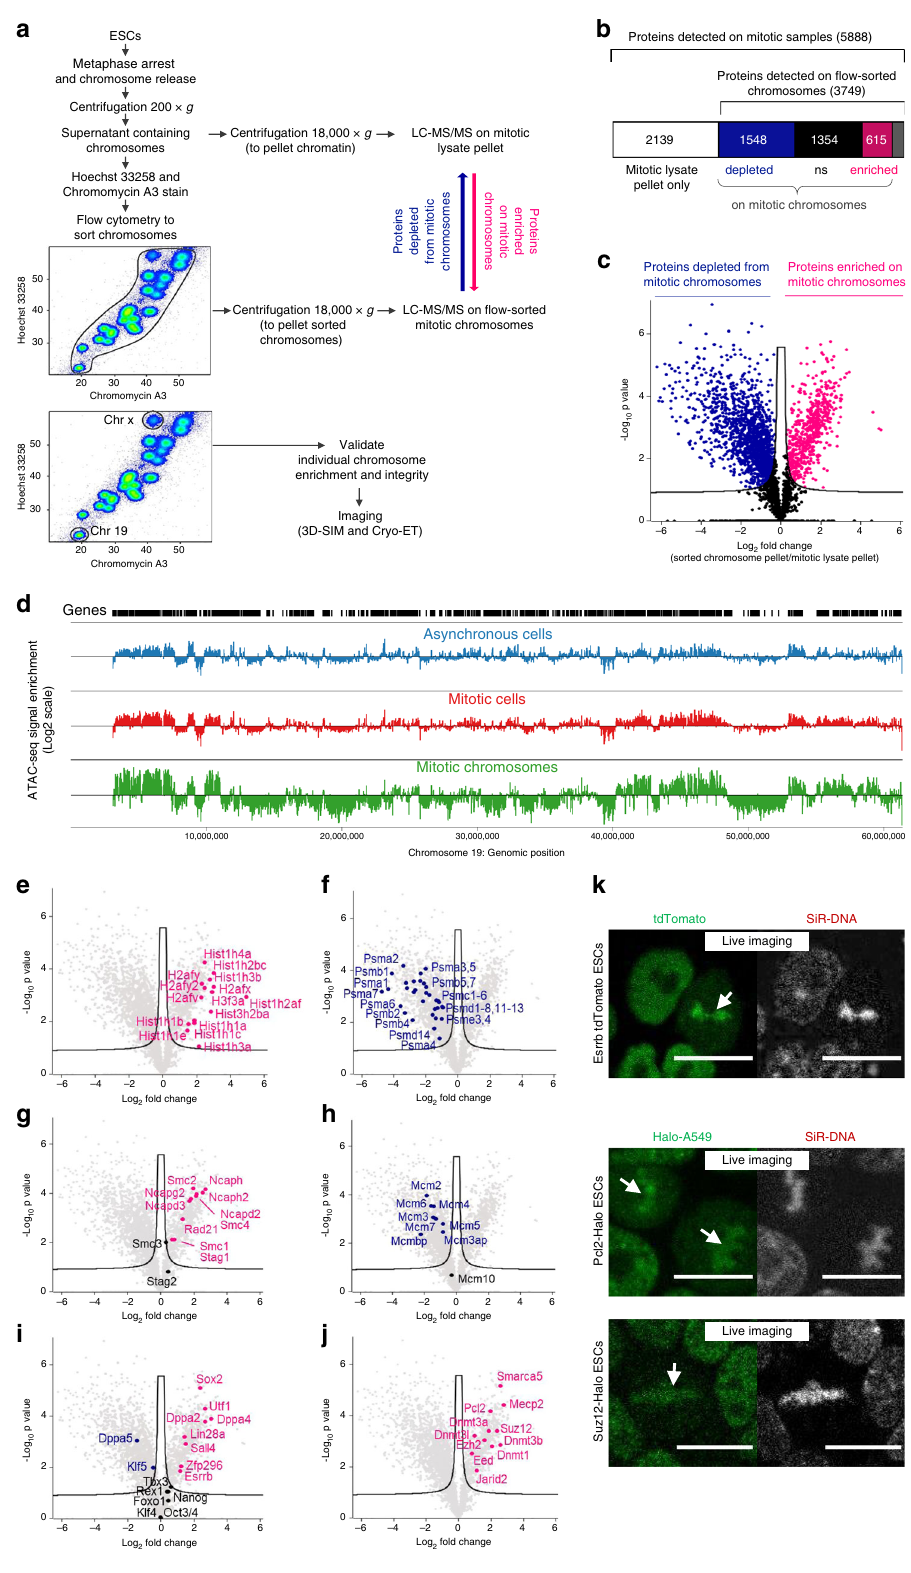
Proteomic comparisons between sorted- and conventional metaphase-arrested samples (Fig. 1e – j) reveal a statistical enrich- ment in histones, Smc-associated proteins and many